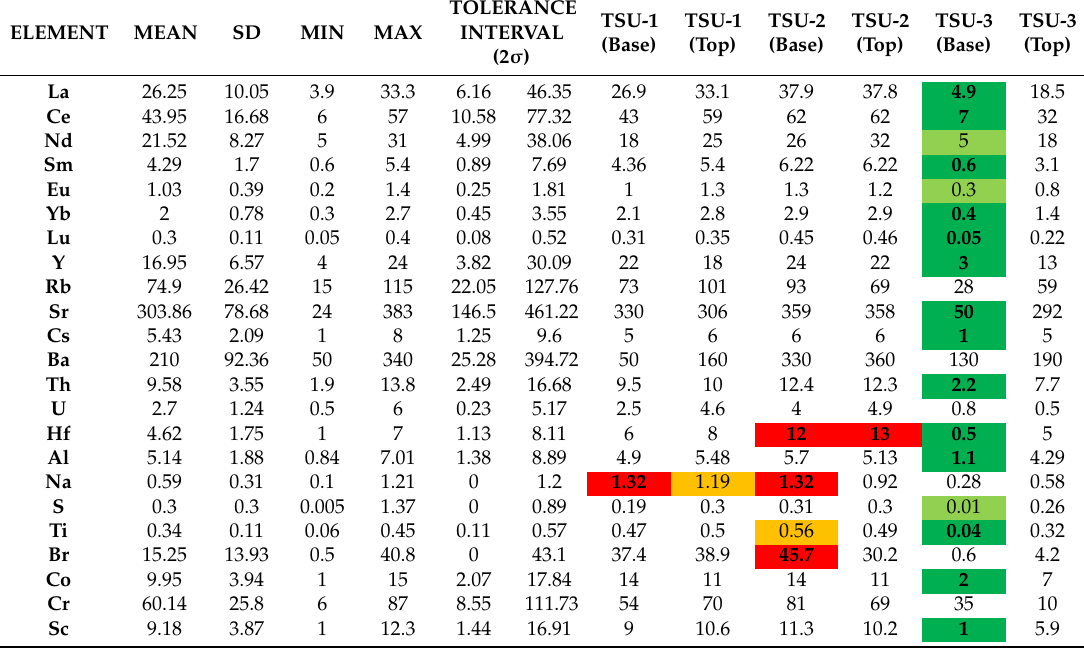
Table 4. Tolerance intervals (2 σ ). Red: positive outliers; orange: almost-positive outliers; dark green: negative outliers; light green: almost-negative